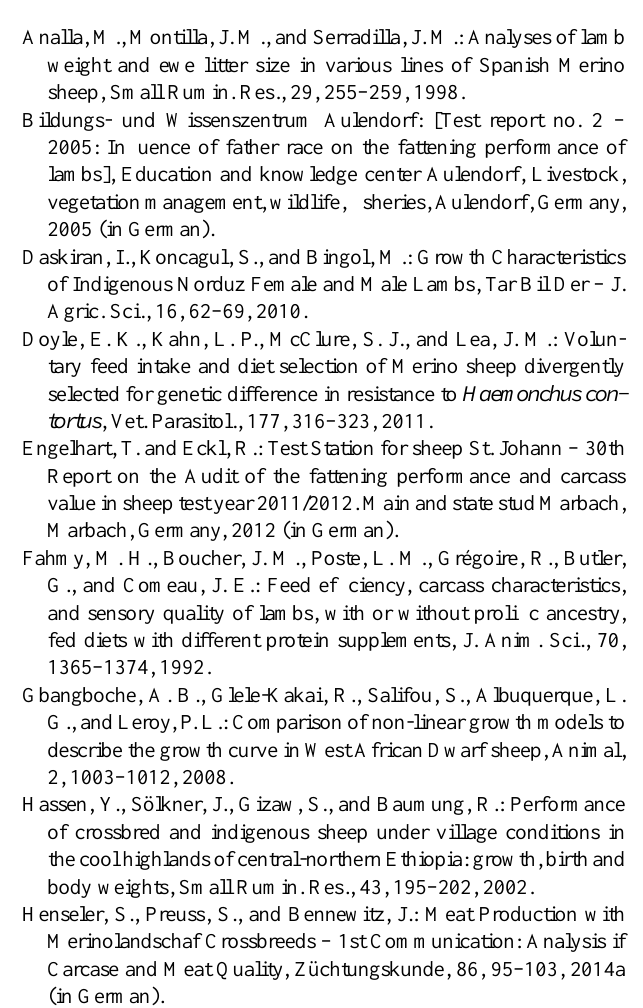
Table 5. Effect of cross, sex and birth type on parameters INT and b of linear regression modelled for fattening